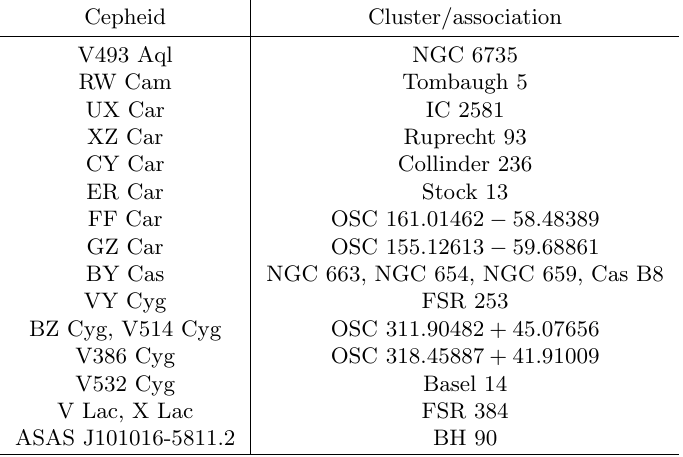
Table 1. The list of Cepheids probably related to the